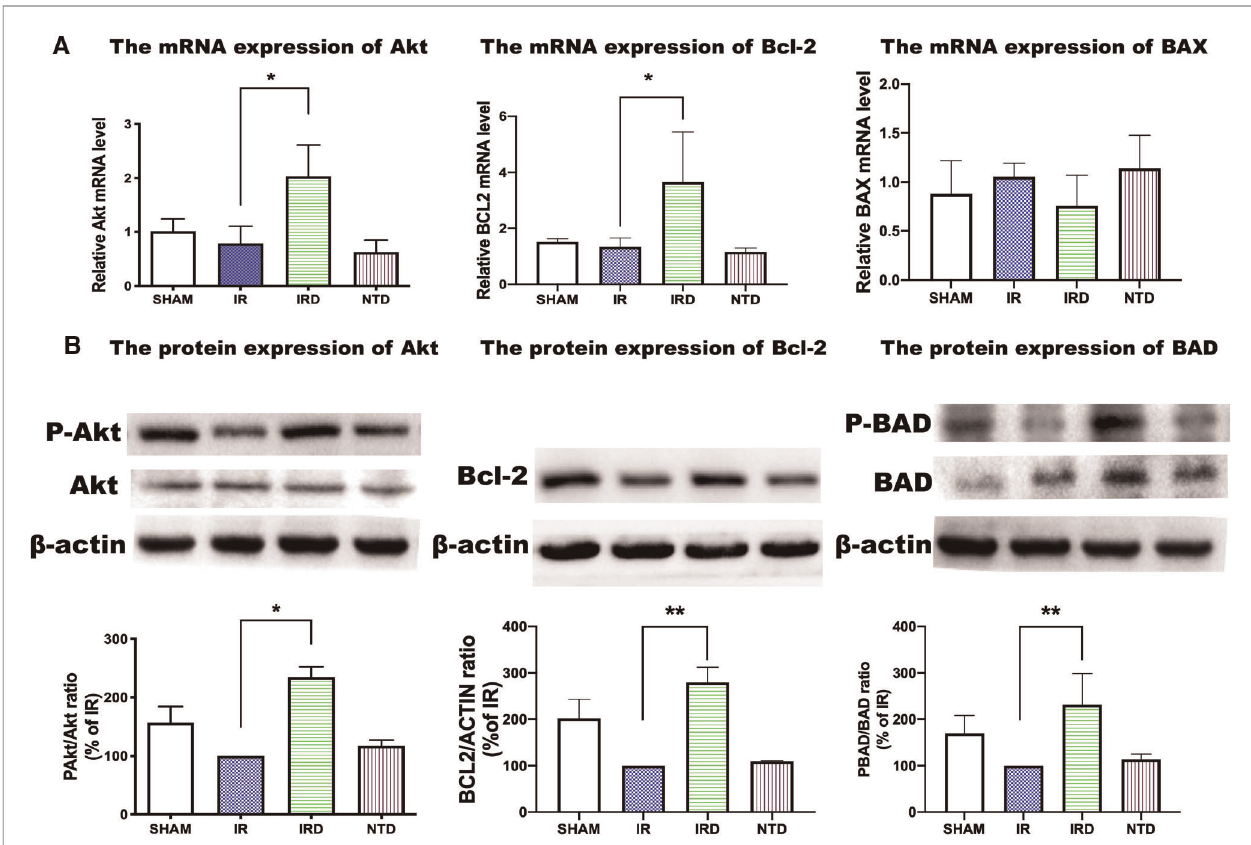
FIGURE 5 | The mRNA and protein expression of the PI3K/Akt pathway in each group. ( A ) mRNA of Akt, Bcl 2 , and BAX measured by qRT-PCR. n =6, * p <0.05 compared with the IR group. ( B ) DADLE upregulated the expression of Akt, Bcl-2, BAD, compared with the IR group; n =6, * p <0.05 compared with the IR group, ** p <0.01 compared with the IR group. IR, IRD, and NTD mean the same as in Figure 2